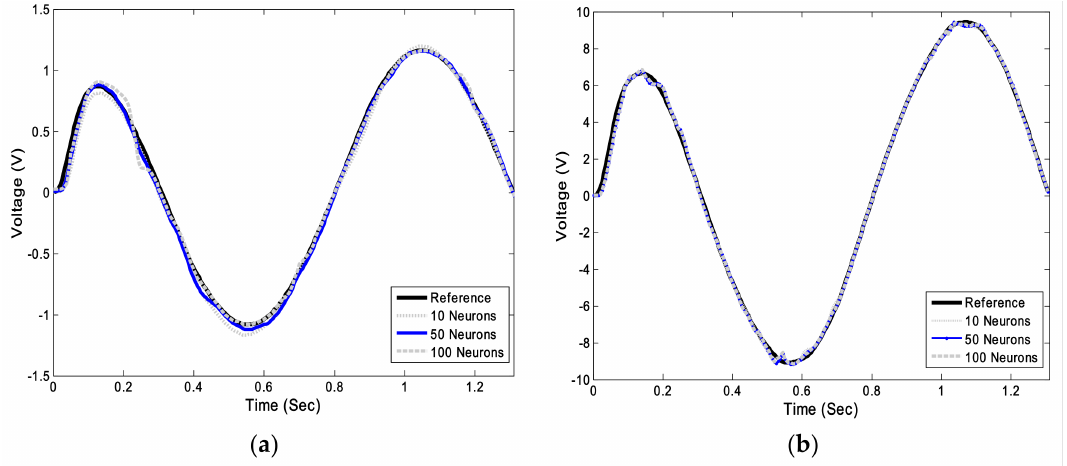
Figure 21. E ff ect of the number of neurons on the response of the trained LS-SVM when ( a ) tested with Data #9; ( b ) tested with Data